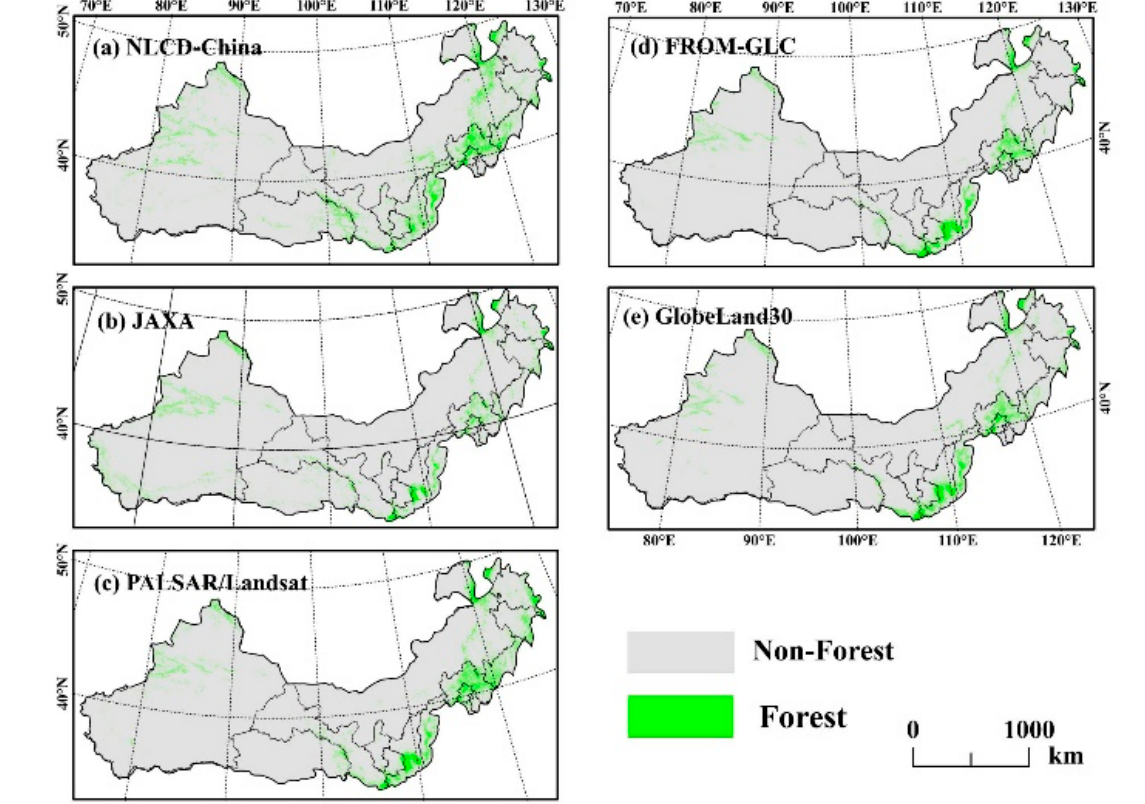
Figure 6. Forest spatial distribution derived from the PALSAR/Landsat-based forest map and other four forest products in 2010. ( a ) NLCD-China forest map; ( b ) JAXA FNF forest map; ( c ) PALSAR/Landsat-based forest map; ( d ) FROM-GLC forest map; ( e ) GlobeLand30 forest map.